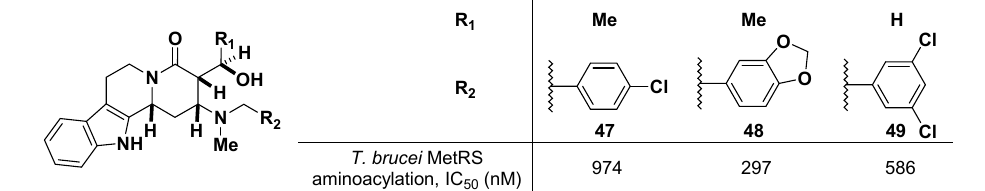
Figure 17. Structures of three tetracyclic carbolines ( 47 – 49 ) and their inhibitory activities against the aminoacylation of Trypanosoma brucei MetRS.